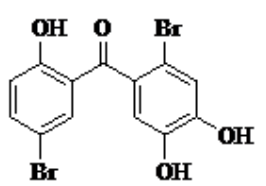
Figure 1 . Chemical structure of the lead compound LM49 . Figure 1. Chemical structure of the lead compound LM49